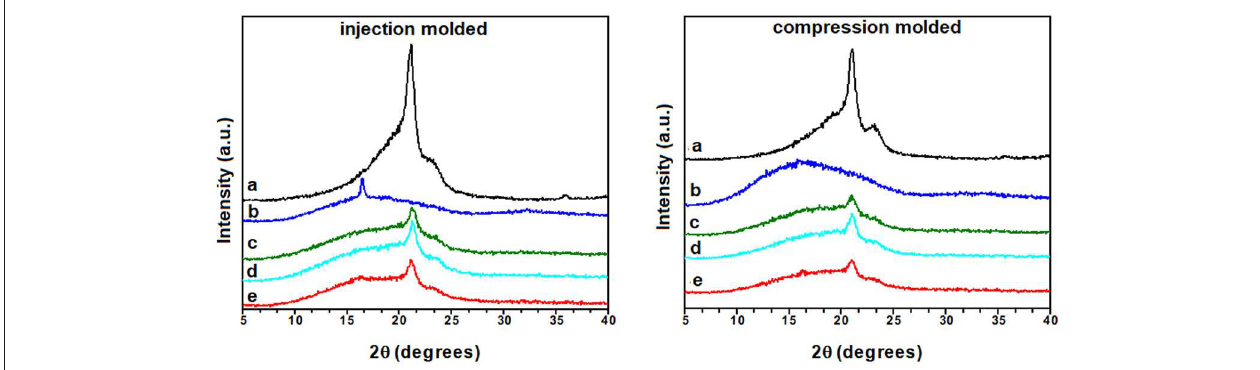
FIGURE 5 | XRD patterns of (a) EVA, (b) PLA, and the PLA/EVA (60:40 wt%) blends loaded with CNT/IL · SO 3 H in the proportion of (c) 0:0; (d) 1:0; and (e) 1:5 phr.